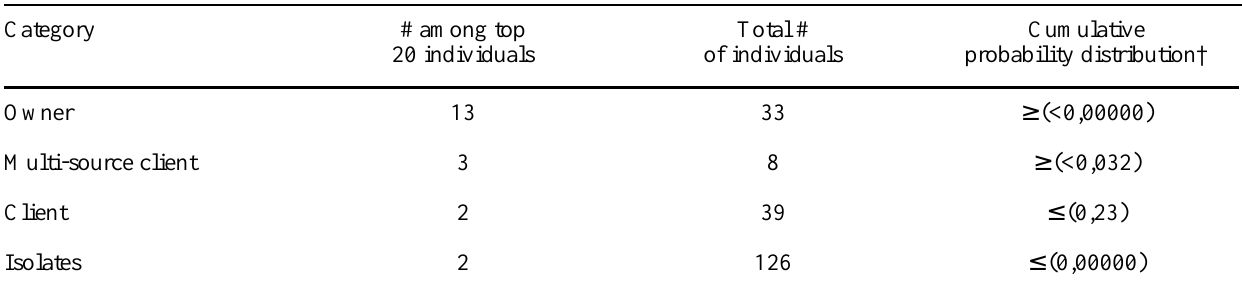
Table 2. Cumulative probability distribution of respondent categories represented among the top 20 individuals, as ranked by degree centrality in the knowledge